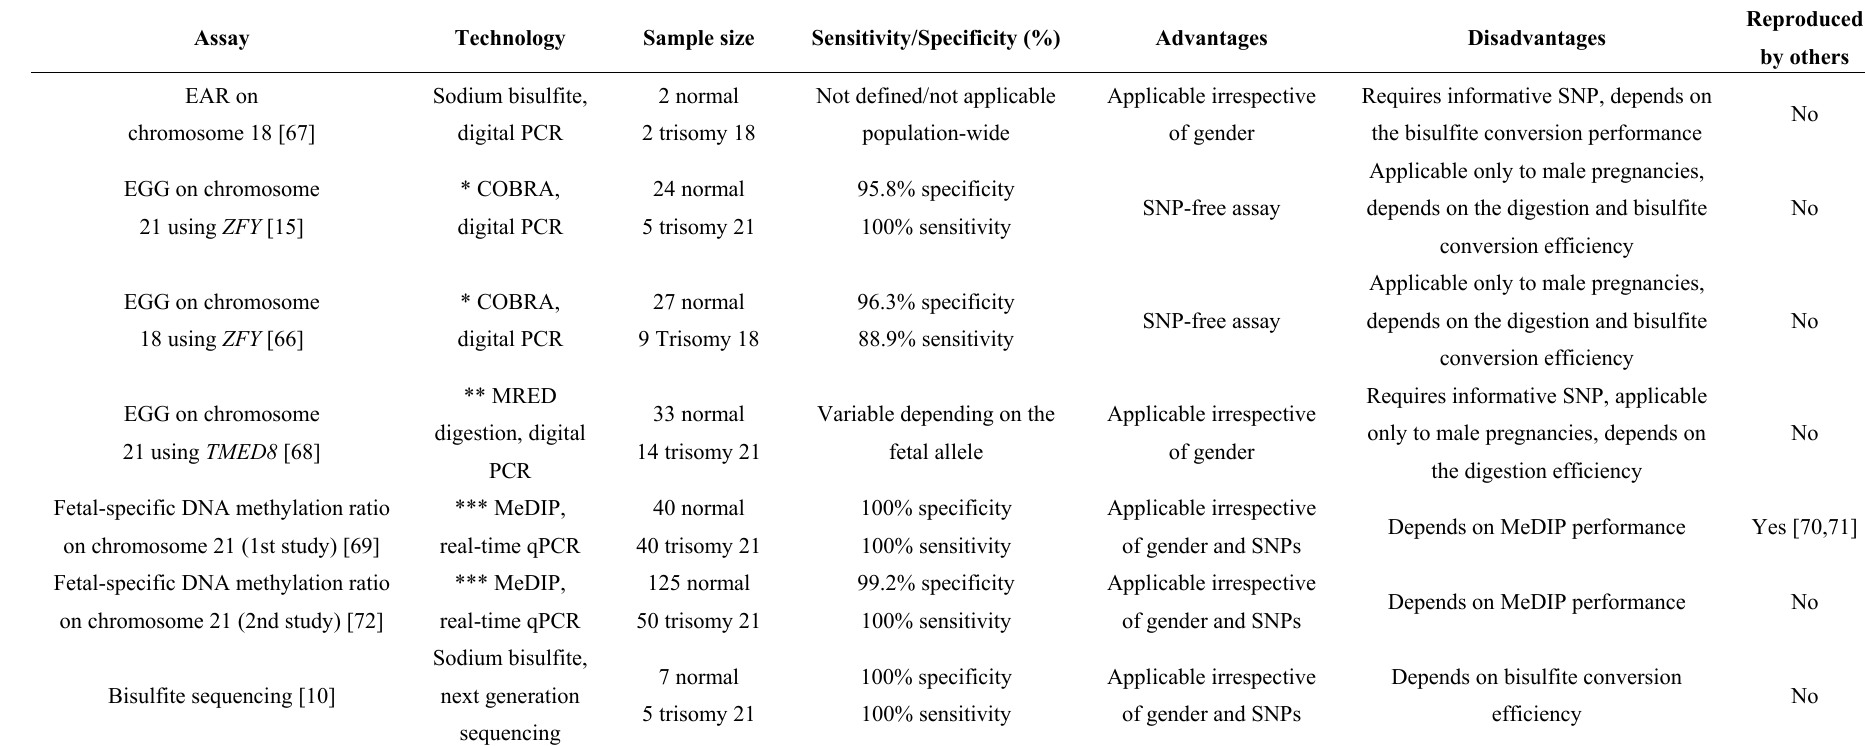
Table 1. Comparison of different methylation-based approaches towards the non-invasive prenatal tests (NIPT) of aneuploidies. EAR, epigenetic allelic ratio (EAR); EGG, epigenetic-genetic; SNP, single nucleotide